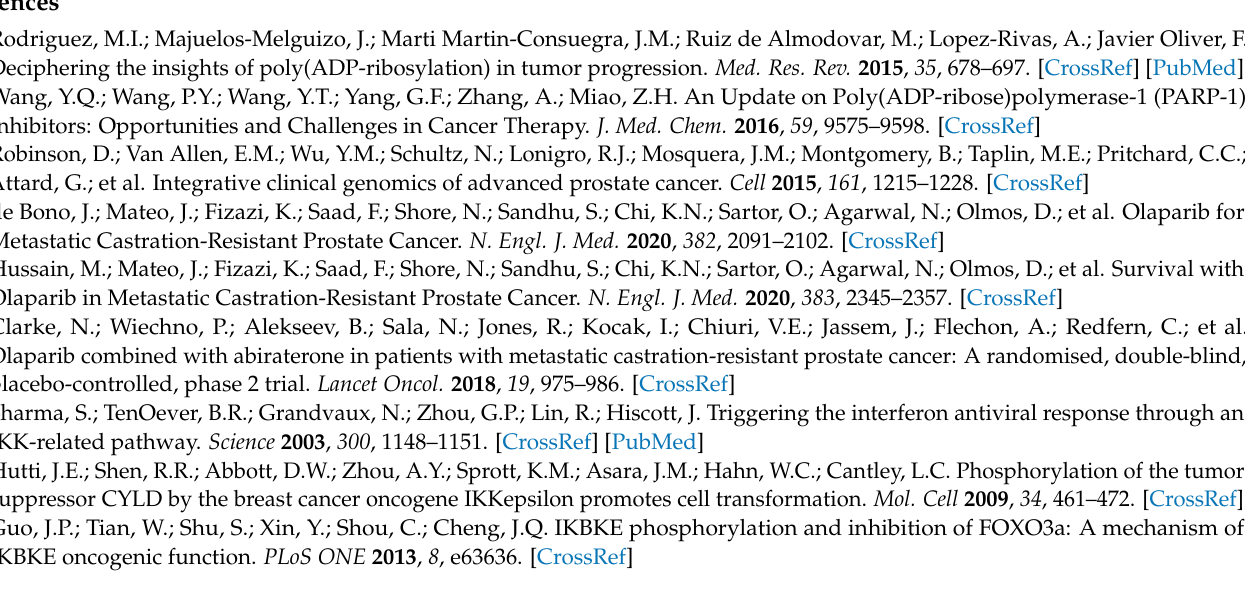
Figure S4: Amlexanox does not inhibit Olaparib-induced Rad51 recruitment and transcription in HSPC cell lines, Figure S5: Full Western blot